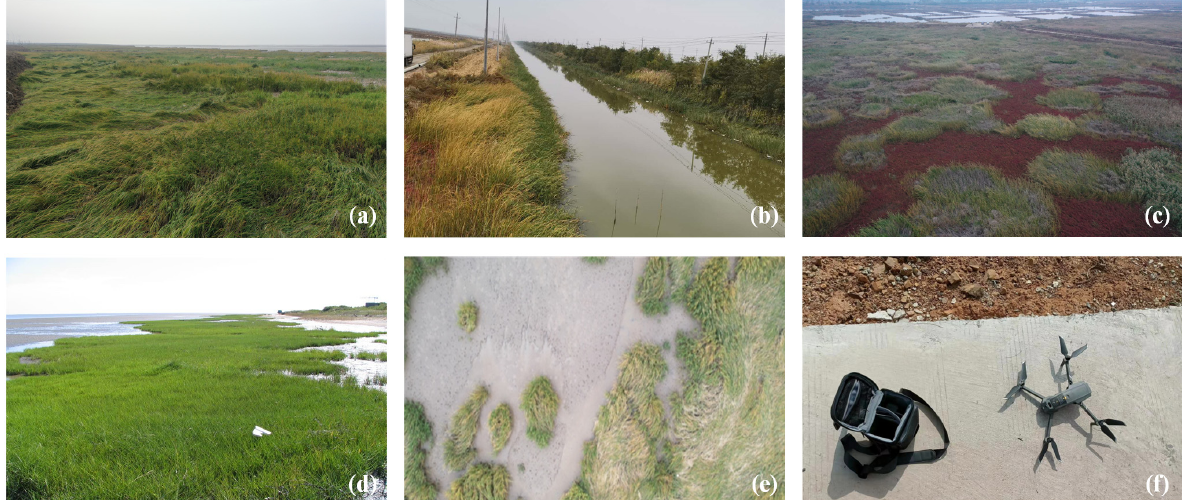
Figure 2. Field survey photographs. ( a ) Spartina alterniflora in a saturated ecological niche; ( b ) S. alterniflora on both sides of the tidal creek; ( c ) S. alterniflora mixed with Suaeda . Suaeda is reddish- brown and S. alterniflora is green; ( d ) S. alterniflora at the forefront of the tidal flat; ( e ) S. alterniflora photographed by drone at an altitude of 30 m; ( f ) drones used to acquire field data. The drone model is DJ Mavic 2.